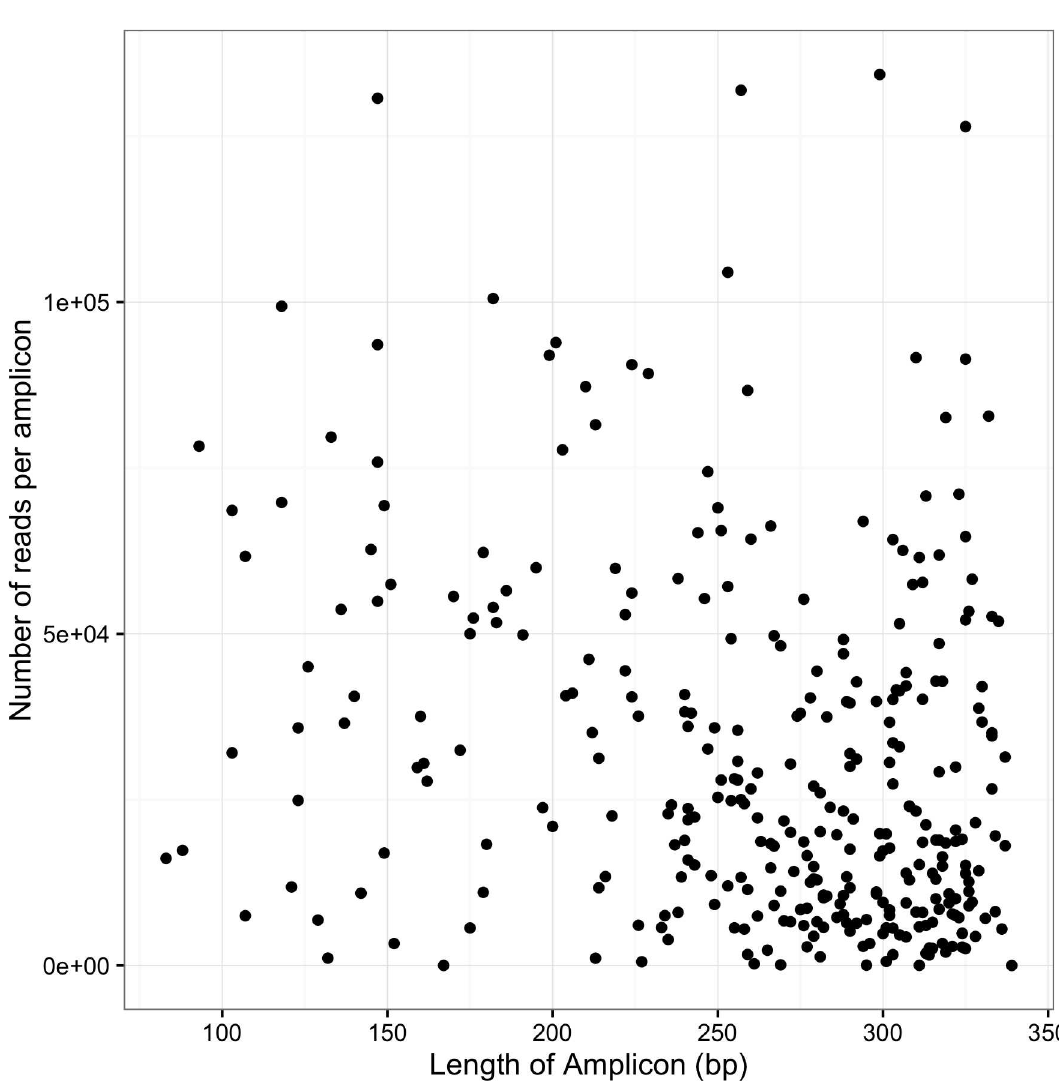
Fig 2. Number of reads per amplicon versus amplicon length. The numberof reads per ampliconhas little relationship with ampliconlength. Long ampliconsare